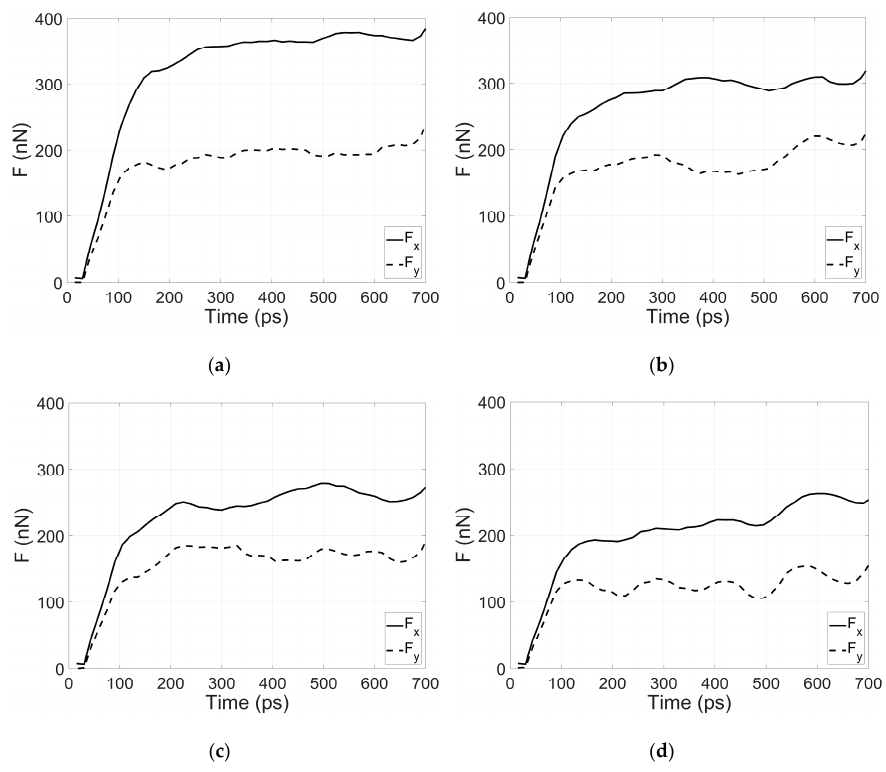
Figure 3. Forces vs. time for ( a ) T w = 300 K, ( b ) T w = 500 K, ( c ) T w = 700 K, and ( d ) T w = 900 K.